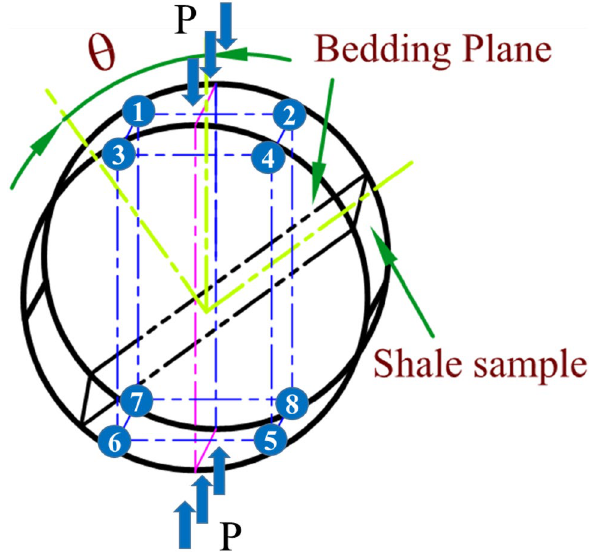
Fig. 2 TAW-100 servo-controlled triaxial testing system and